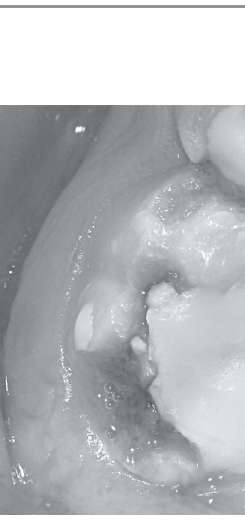
Figure 2. Tooth breakdown and protective material at 6-month evaluation.